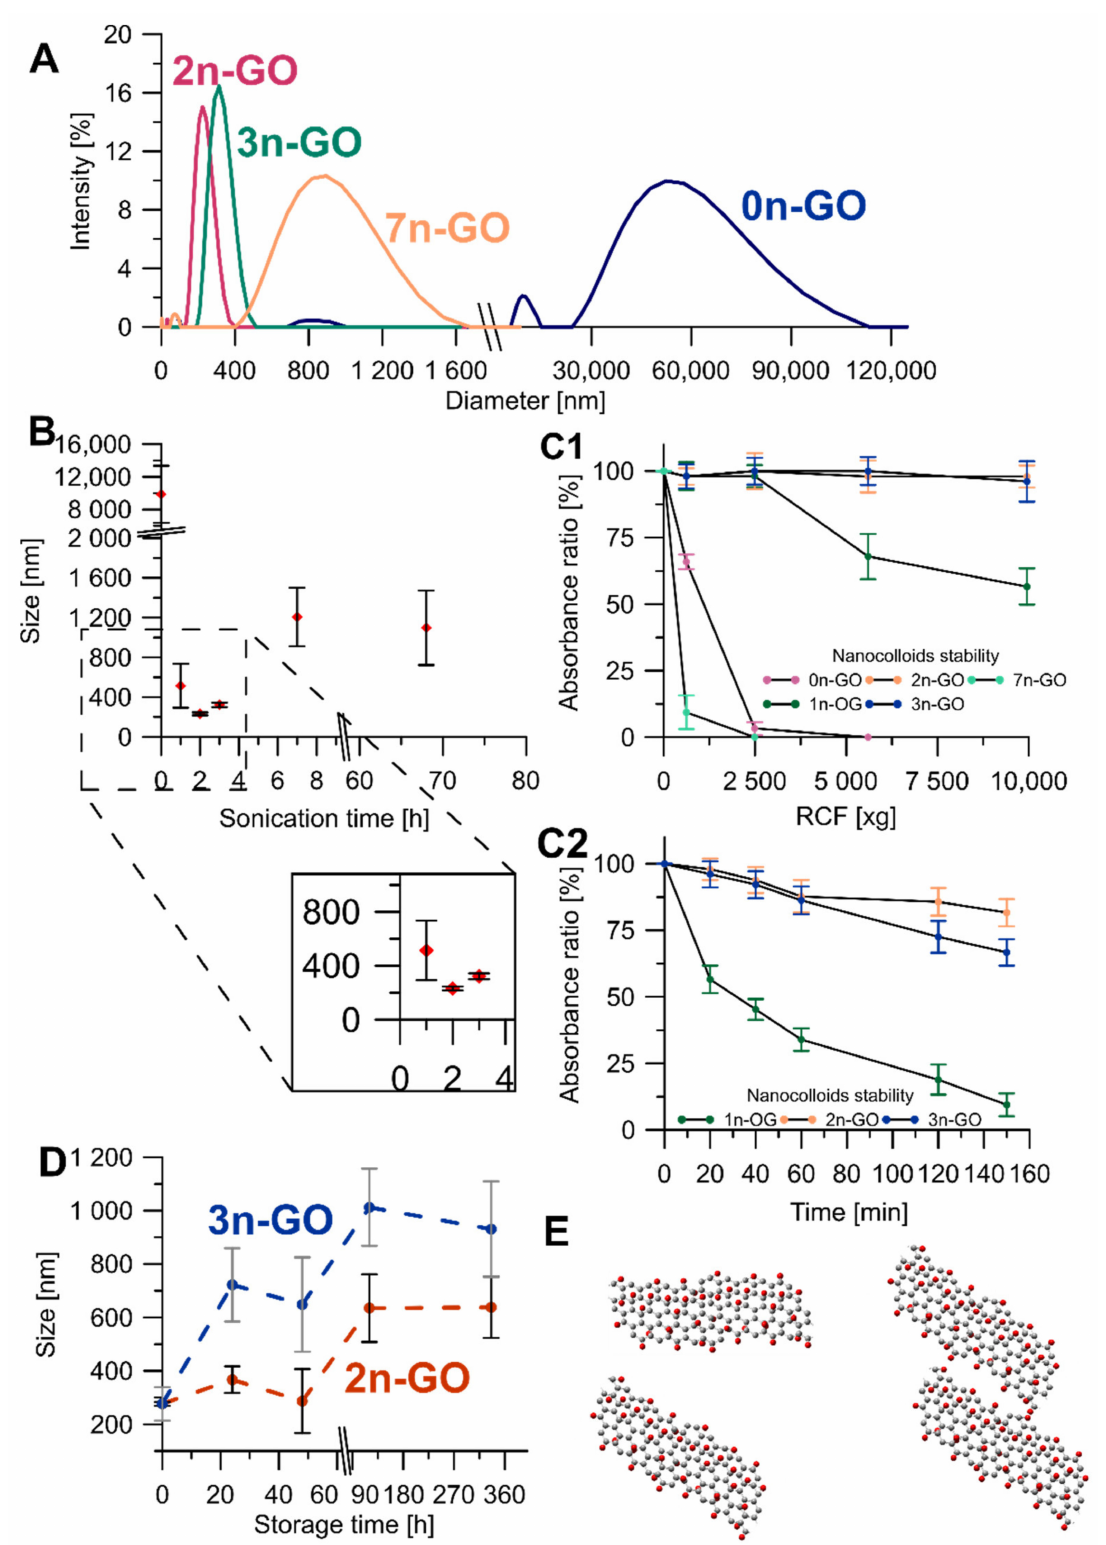
Figure 2. ( A ) The Xn-GO size distribution obtained from dynamic light scattering (DLS) analyses; ( B ) the Xn-GO size as a function of ultrasonication time; ( C ) nanocolloids stability as a function of centrifugation 1— force and 2—time; ( D ) comparison of 2n-GO and 3n-GO nanocolloid’s time stabilities (note that the dashed lines are for visualization only); ( E ) model of a successive aggregation